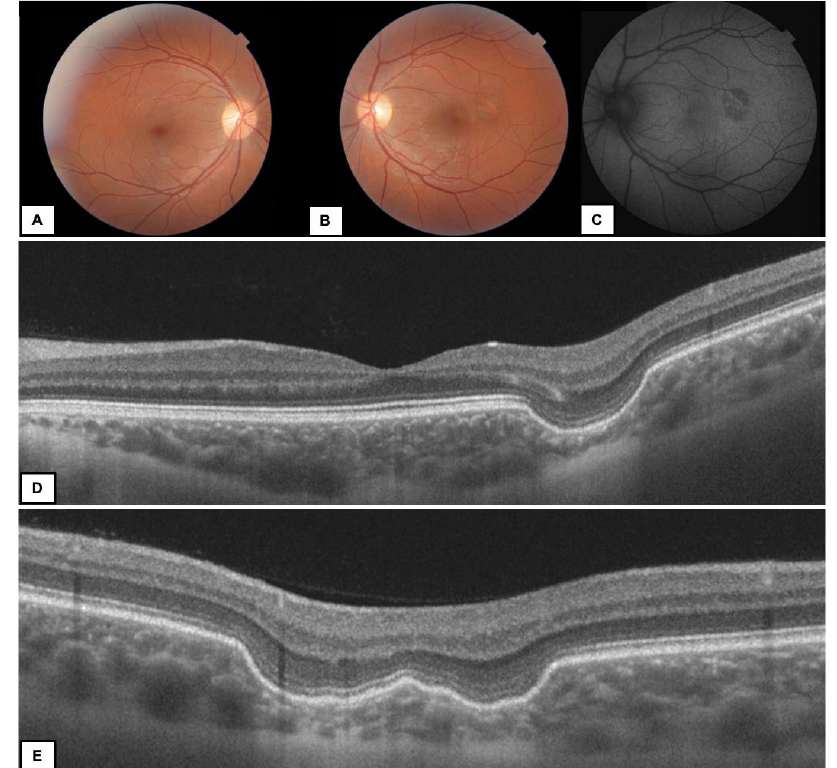
Figure 2. A 37-year-old woman with FCE type 1 in the left eye (LE). Color fundus photography ( A ) RE — normal fundus ( B ) LE — yellow – grey round area of FCE located juxtafoveally ( C ) FAF — irregular hypoautofluorescence in the area of FCE corresponding to the RPE changes ( D , E ) OCT B-scans — different projections of the choroidal ectasia on radial scans (double-bowl-shaped FCE).